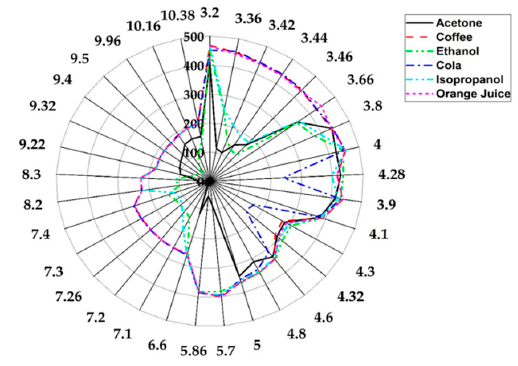
Figure 13. Radar plot of raw values of sensor responses for chemical standards and complex mixtures, across the entire infrared range (3.1–10.5 µm).